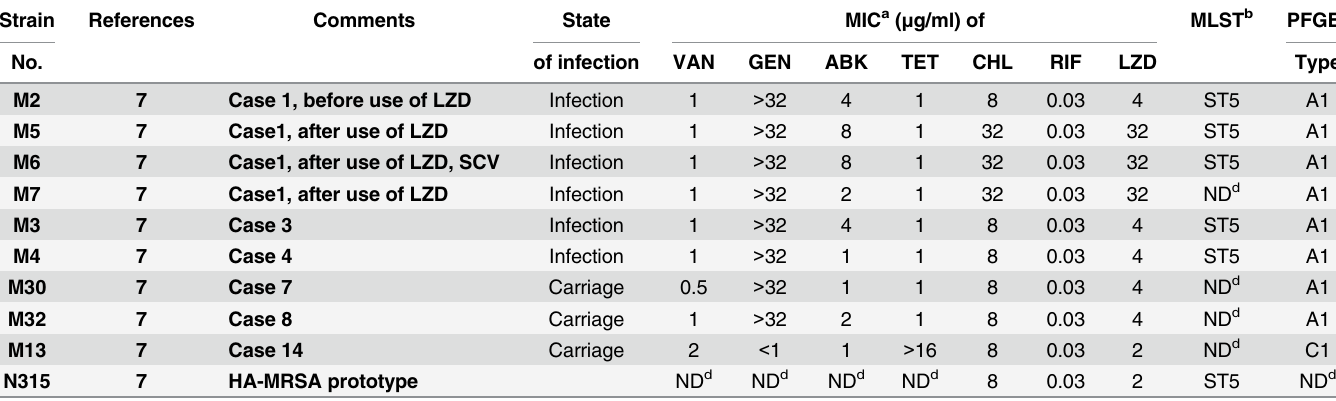
Table 1. List of strains